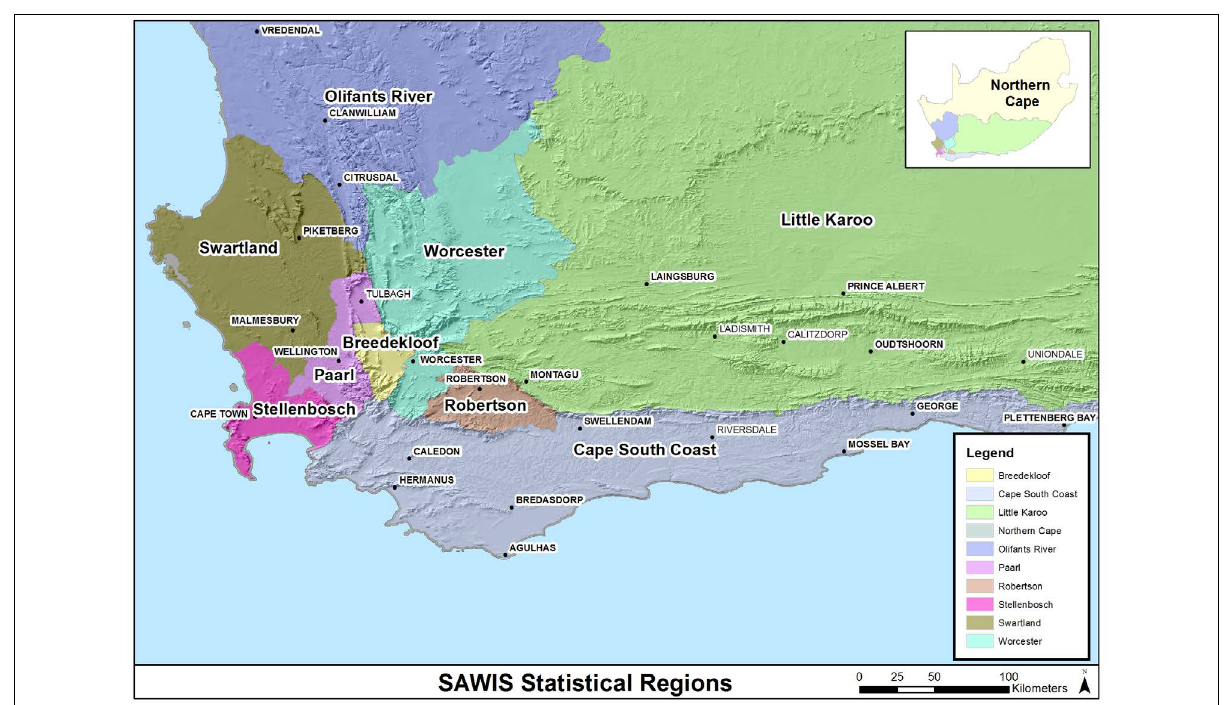
figure 2: The wine production regions as defined by the South African Wine Industry Information & Systems 60 . table 1: Farm size and cultivated area for each relatively homogeneous area in the Breede River area